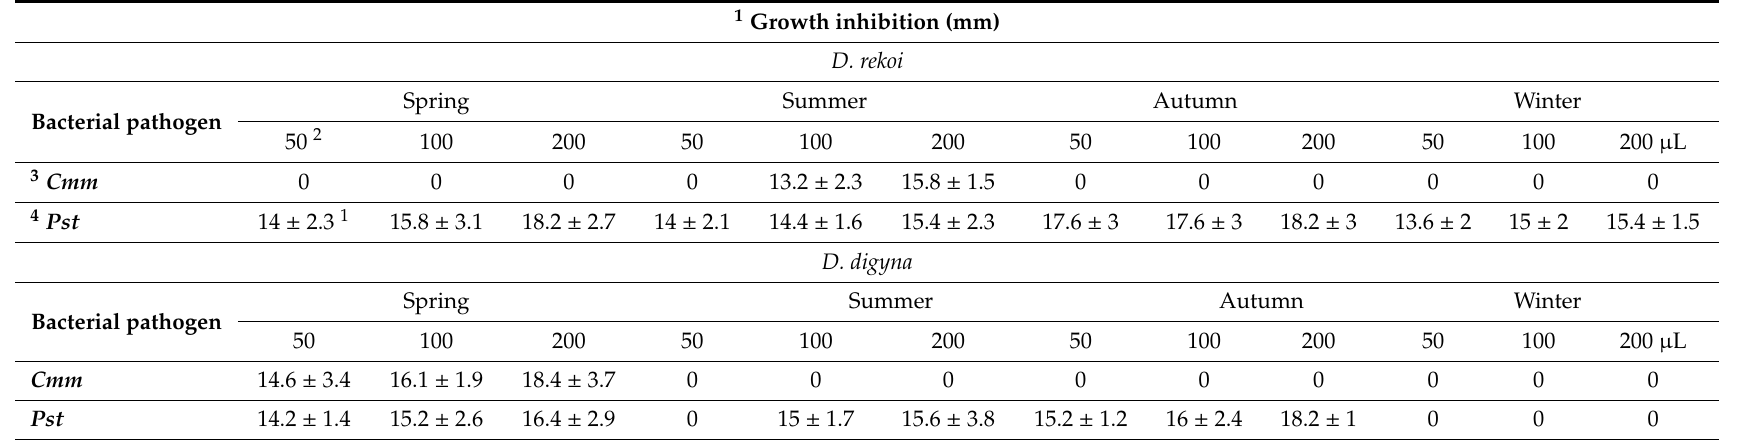
Table 3. Antibacterial activity in leaves of two contrasting Diospyros tree species. Methanolic extracts were obtained from the combined leaves ( n = 8) sampled from the canopy of five D. digyna and D. rekoi trees at di ff erent locations and seasons for the duration of 2014. 1 Growth inhibition